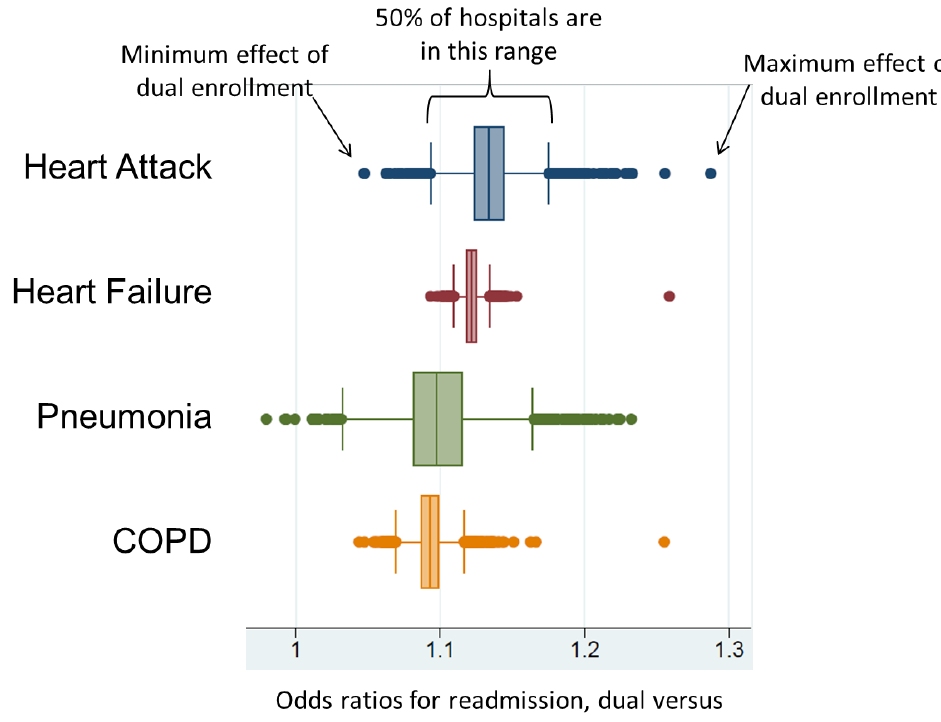
Figure 5.3. Consistency of Dual Enrollment